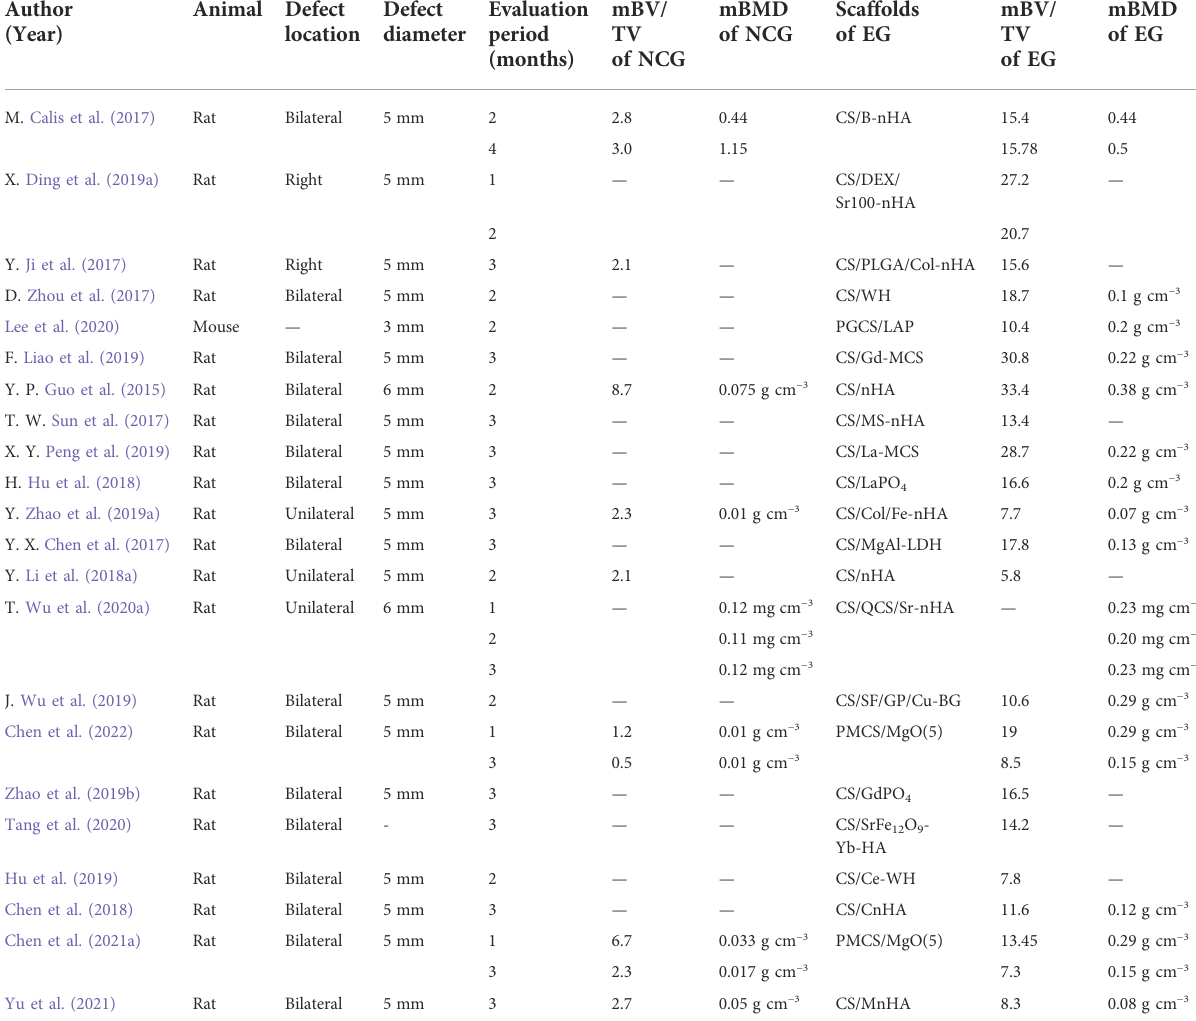
TABLE 6 Surgery details and quantitative assessment results of micro-CT. NCG: negative control group; EG: experimental group. Author